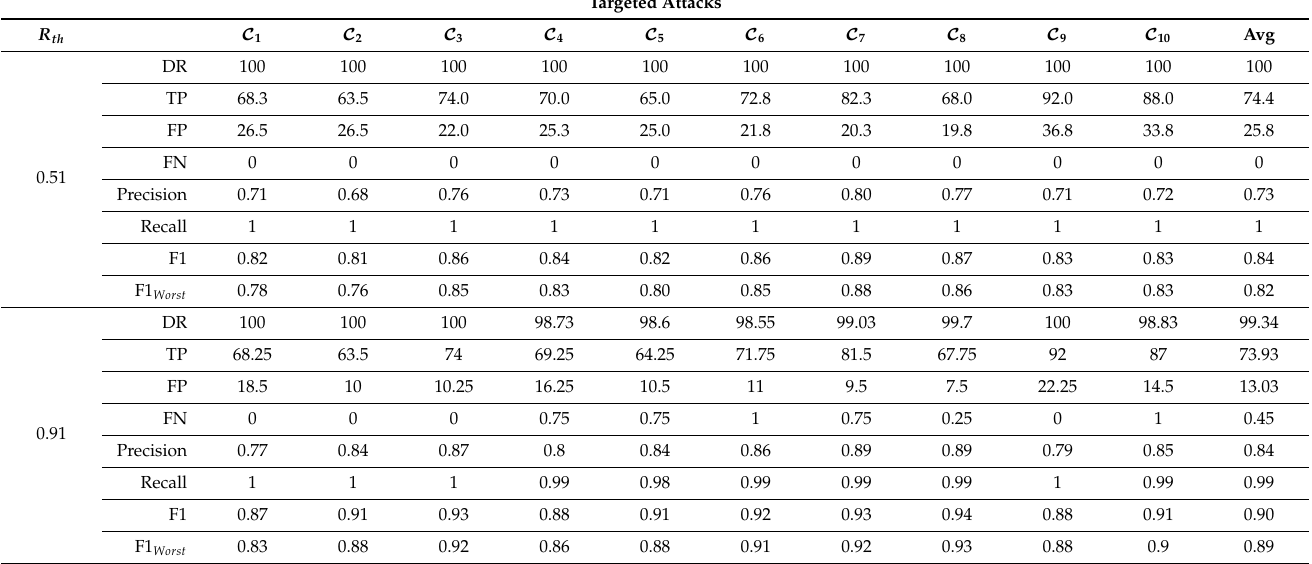
Table 13. Average for all indicators (worst case for F1) per CNN over all 4 targeted attacks.